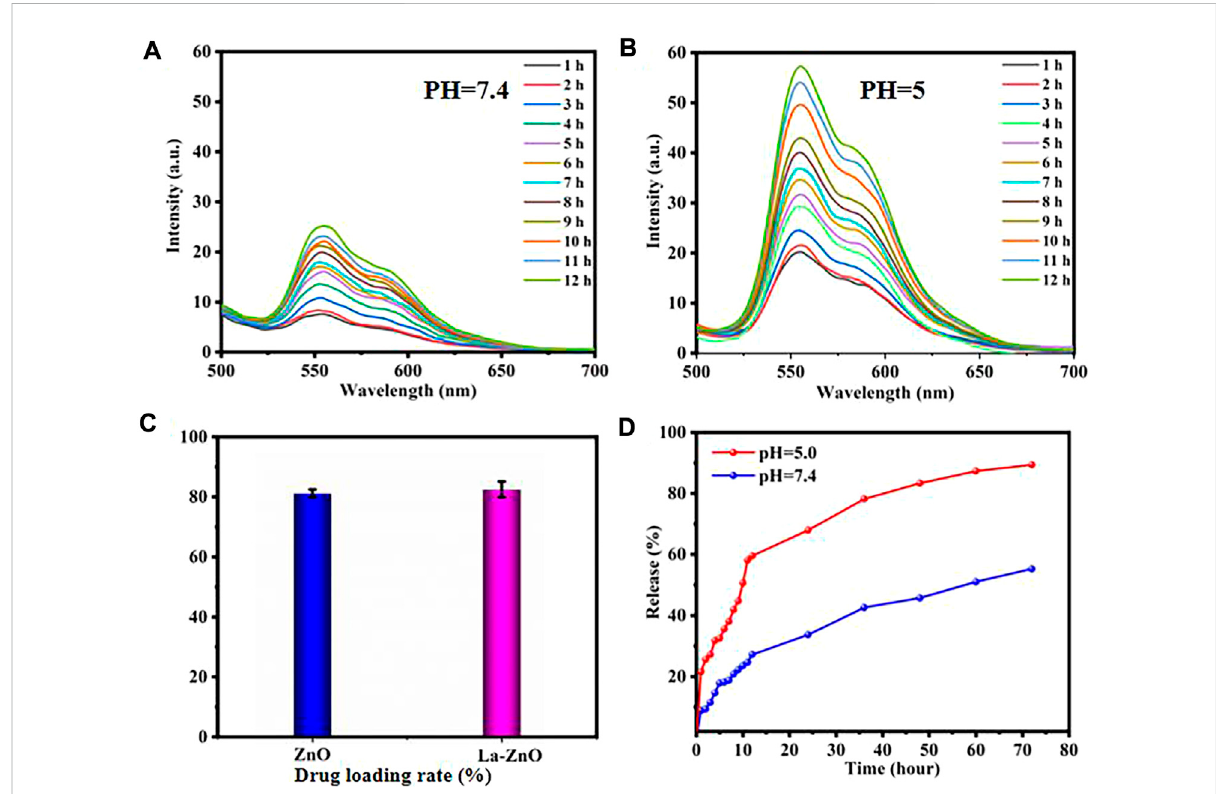
FIGURE 8 Time-dependent fl uorescence spectra of DOX release after incubating La-ZnO-DOX at pH 7.4 (A) and pH 5.0 (B) . (C) Drug loading rate of pure ZnO and La-ZnO. (D) Drug release rate of HA-PEG-NH2-Zno-DOX drug loading system at pH = 5.0 and 7.4 with